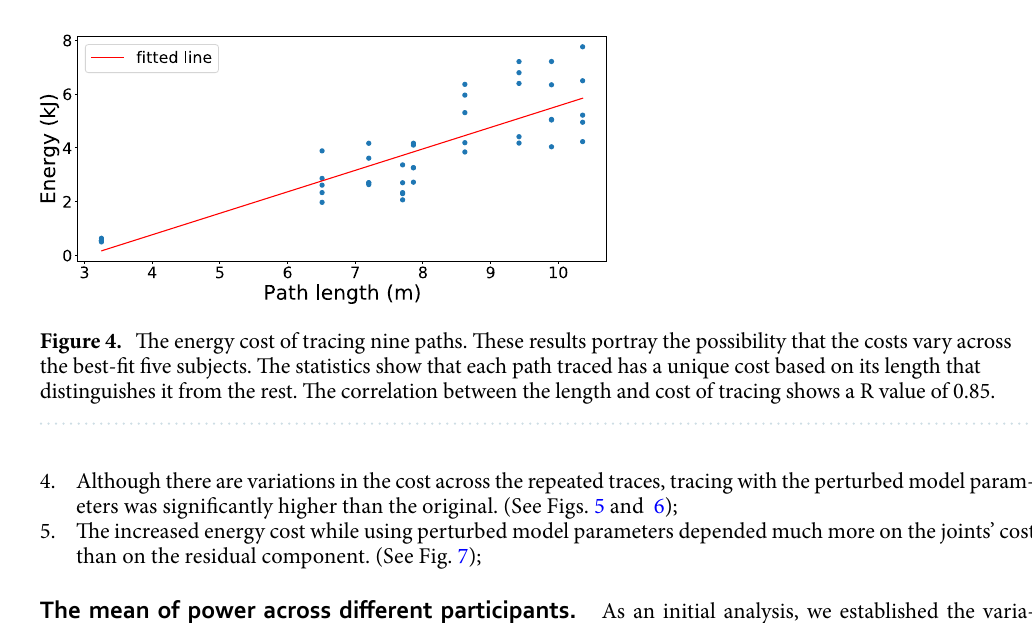
tions in the energetic costs for tracing path1 exhibited by different subjects. Fig. 2 illustrates the mean and the standard deviation of powers across subjects at each frame. The result reveals that subjects put similar effort at the same points along the path. Thus although the total cost of the movements may vary between subjects, the power patterns are qualitatively very similar. The VR experiment 26 showed that participants used similar pos- tures sequences while tracing the same curves from a kinematic perspective. It is expected that the instantaneous